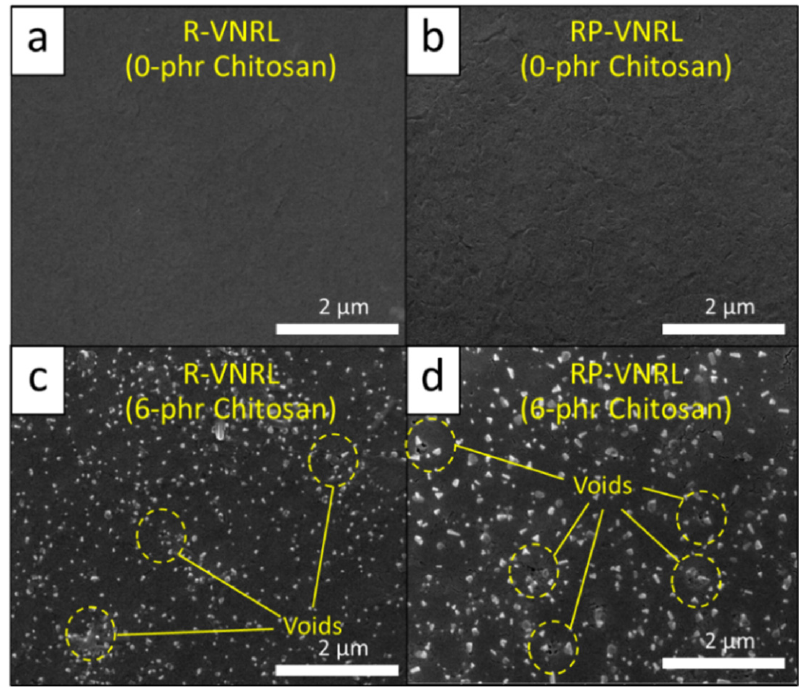
Figure 5. SEM images showing morphological properties of ( a ) pristine R-VNRL, ( b ) pristine RP- VNRL, ( c ) 6-phr CS/R-VNRL composites, and ( d ) 6-phr CS/RP-VNRL composites. All images are at a magnification of ×20,000.